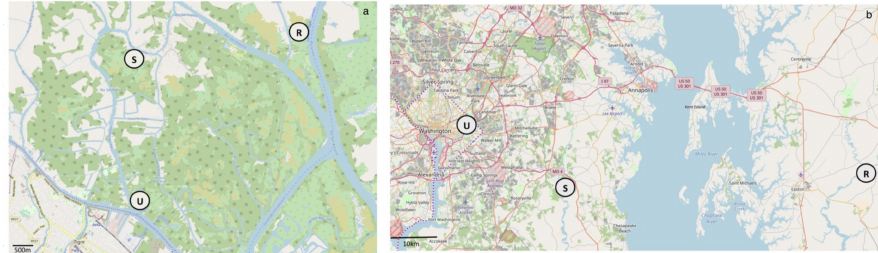
Figure 1. Location of sampling sites in Buenos Aires ( a ) and Washington D.C. ( b ). U = urban, S